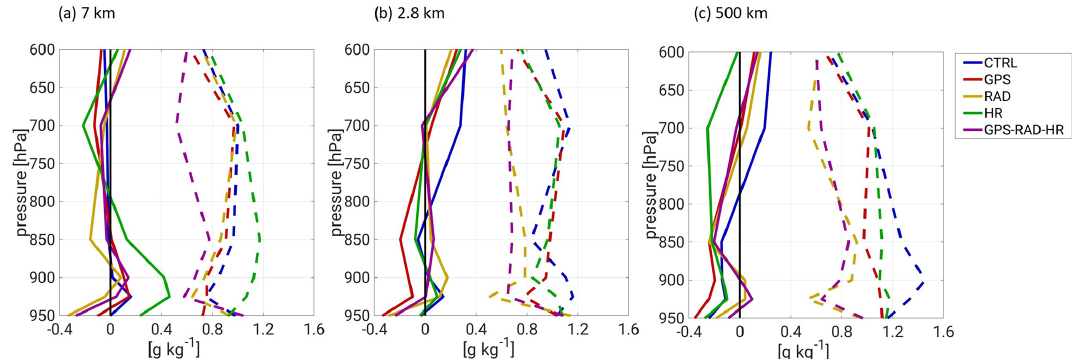
Figure 8. Mean biases (solid lines) and RMSE (dashed lines) of specific humidity between the operational soundings for (a) the 7km, (b) 2.8km, and (c) and 500m simulations. The differences are obtained at the four stations within the investigation area RhoAlps (Milan, Nîmes, Udine, San Pietro) and are averaged for all stations and for the complete simulation period (00:00 UTC 22 September to 00:00UTC 25 September 2012).